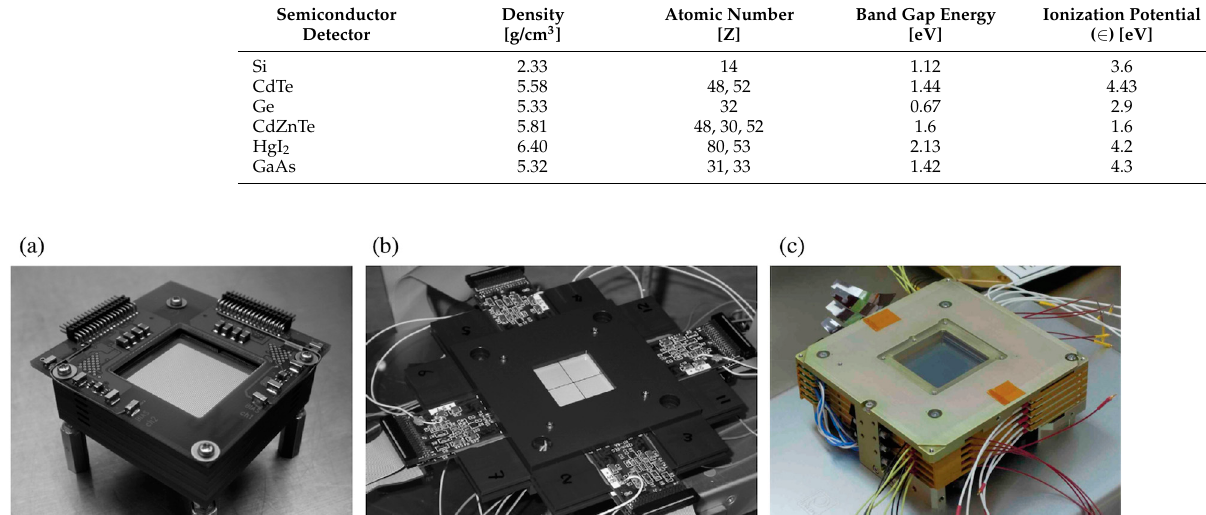
Figure 3. Photographs of ( a ) multilayered DSSDs stack [65], ( b ) the CdTe detectors stack [65], and ( c ) the prototype Si/CdTe Compton camera [66]. Reproduced with permissions from Watanabe et al. [65] and Takeda et al. [66].